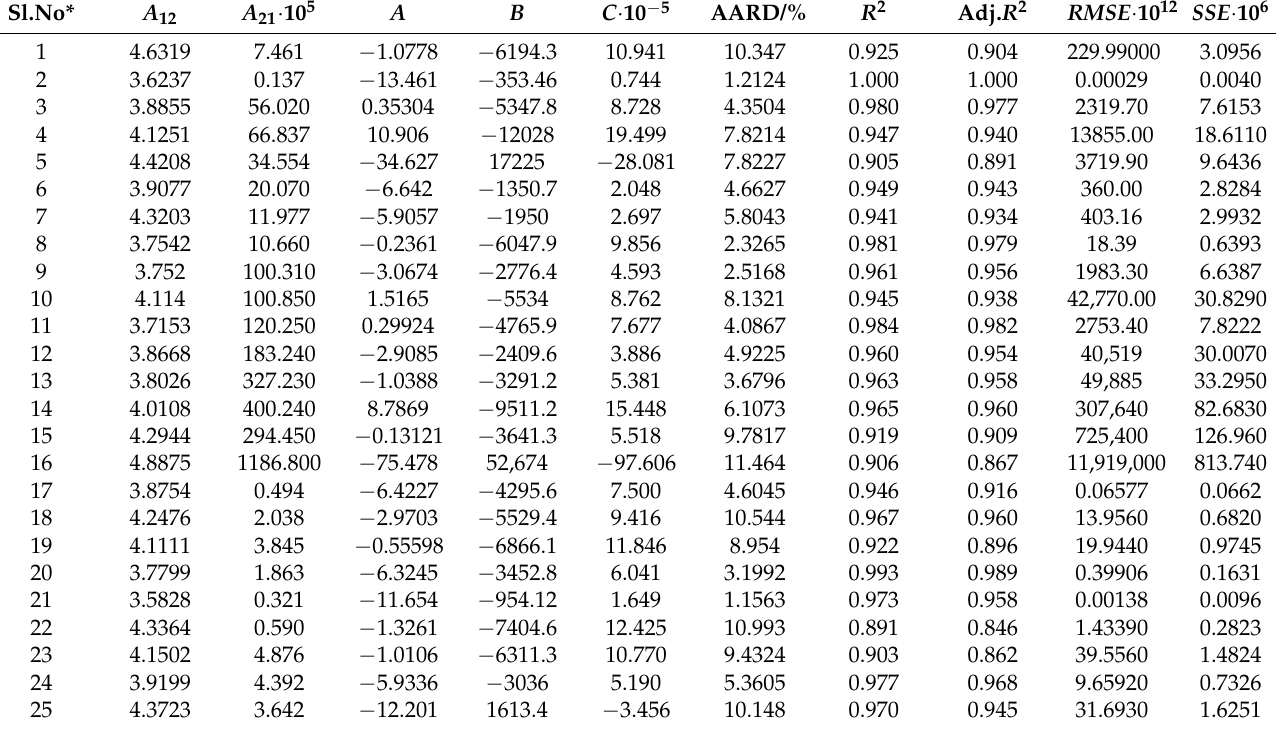
Table 5. Correlation constants of the new model 2 (Equation (21)).